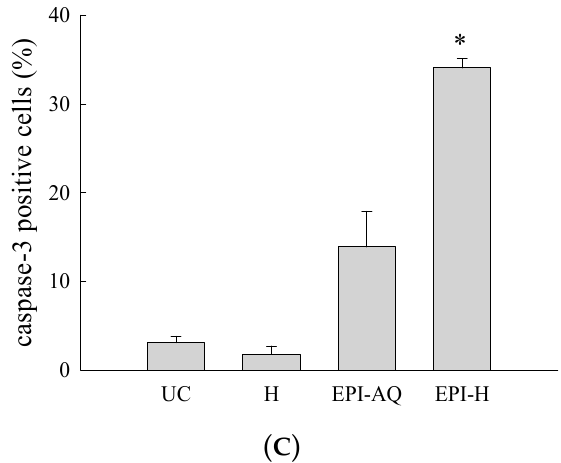
Figure 7. EPI-H enhanced antitumor efficacy in F344/AY-27 rat model. ( A ) Histopathologic findings with H&E staining showed normal urothelium; urothelium carcinoma (UC), and UC treated with H, EPI-AQ, EPI-H, and the enlarged image of yellow box in EPI-H. The yellow arrowheads indicated apoptotic nuclei. ( B ) Immunofluorescence of bladder section showed caspase-3 (green) and DAPI (nuclei, blue) in UC, H, EPI-AQ, and EPI-H groups. (magnification, 200×) ( C ) Quantitative analysis of caspase-3 in immunofluorescence images. Average of the positively stained area was evaluated from three randomly selected observation fields in each bladder section. * p < 0.001, compared with the EPI-AQ group.